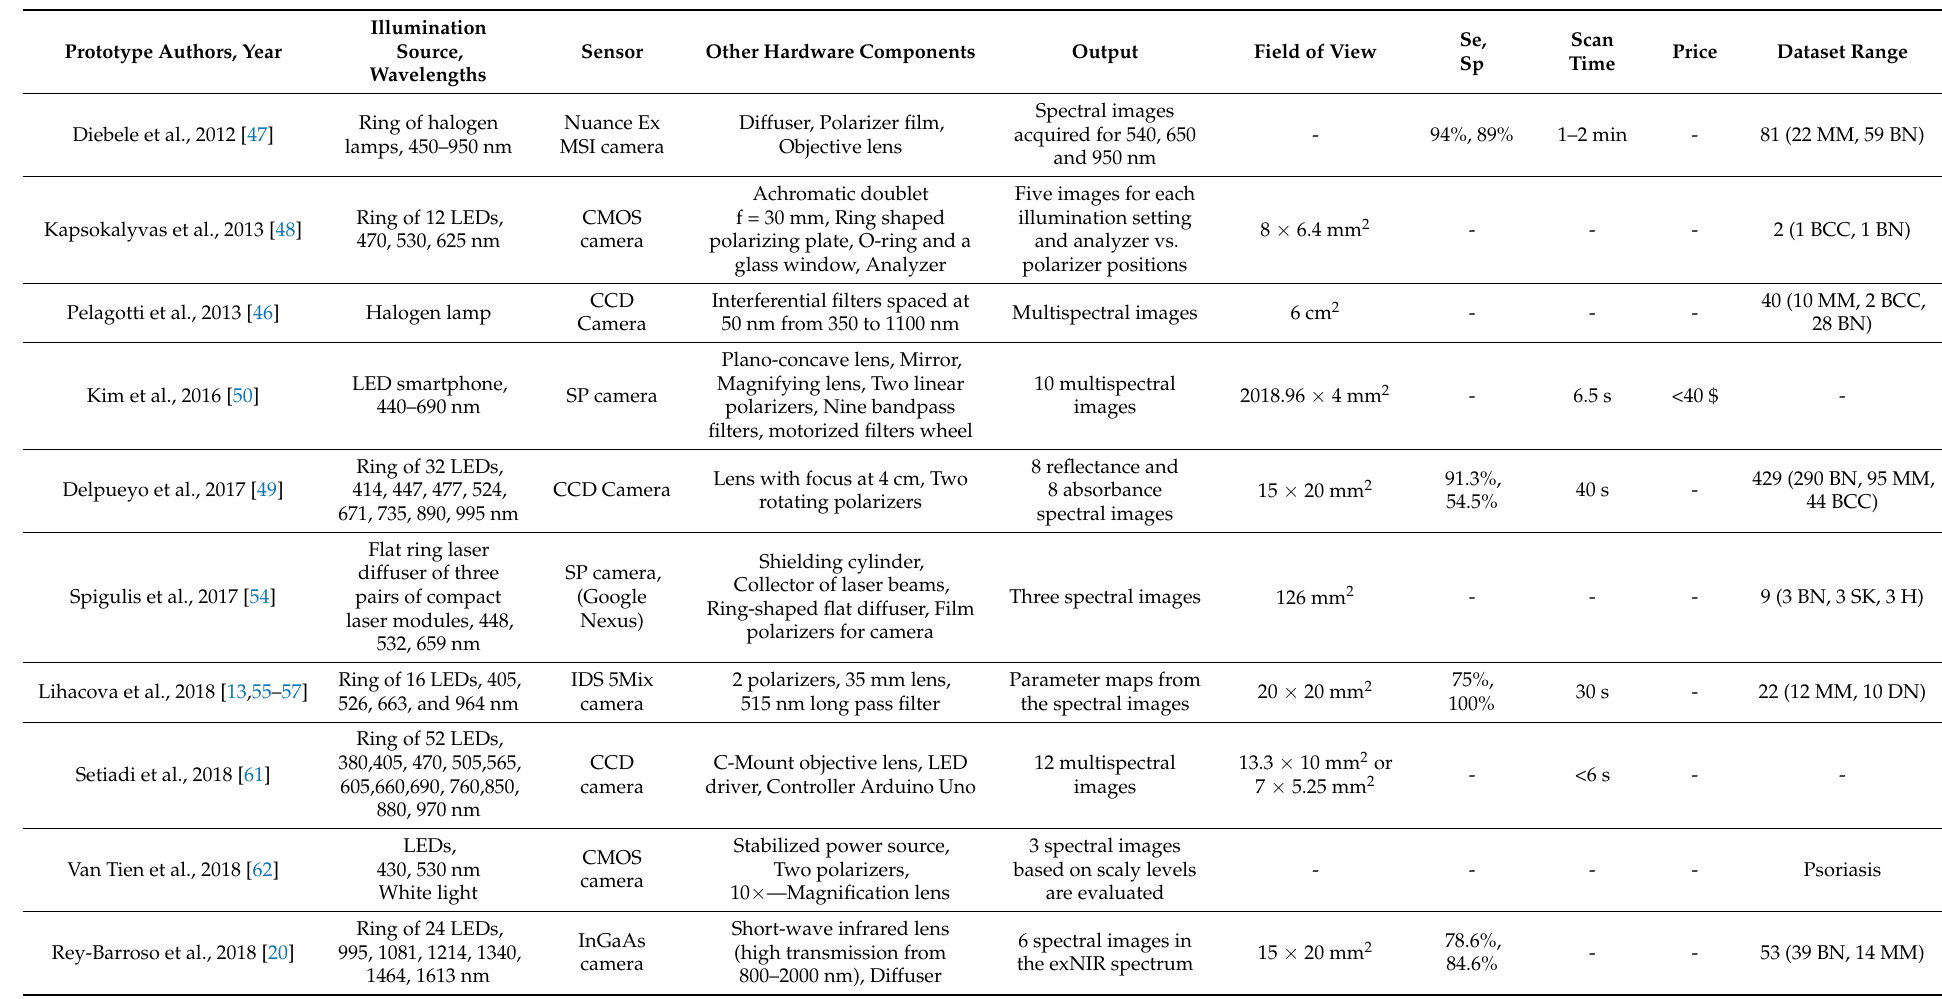
Table 5. Features of multispectral imaging prototypes developed for